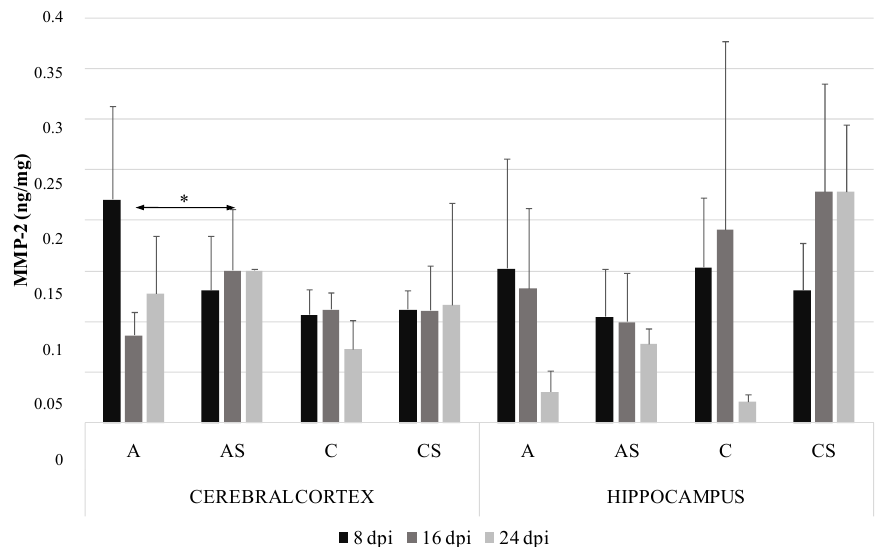
Figure 1. Matrix metalloproteinases-2 (MMP-2) level (ng/mg protein) in the cerebral cortex and hippocampus in control and infected groups at 8, 16 and 24 days post Acanthamoeba spp. infection (dpi). Data represent means ± SD for 6 independent experiments. C, immunocompetent uninfected control group mice; CS, immunosuppressed uninfected control group mice; A, immunocompetent Acanthamoeba spp. infected mice; AS, immunosuppressed Acanthamoeba spp. infected mice; * p ≤ 0.05 for the significance of difference (Mann–Whitney U test).